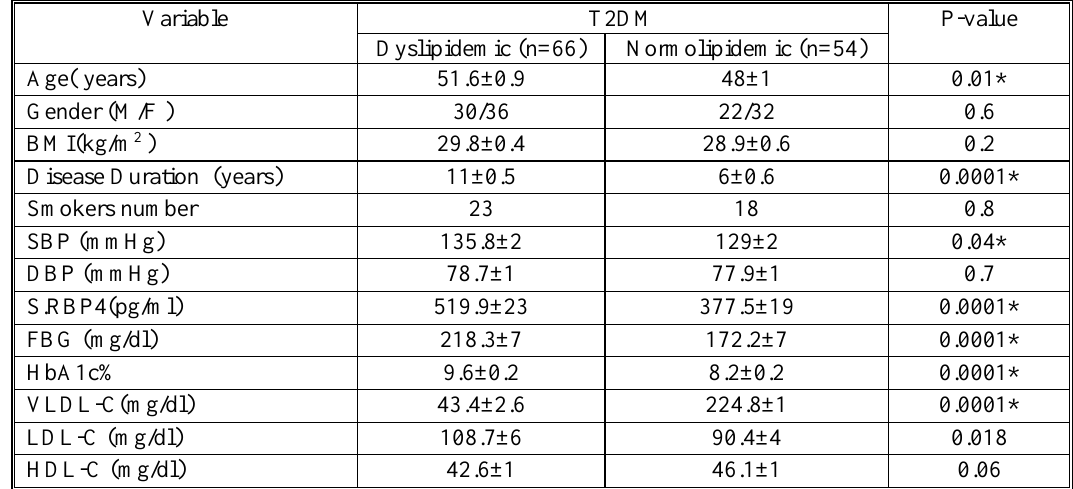
Table- 1. Characteristics of dyslipidemic and normolipidemic T2DM patients